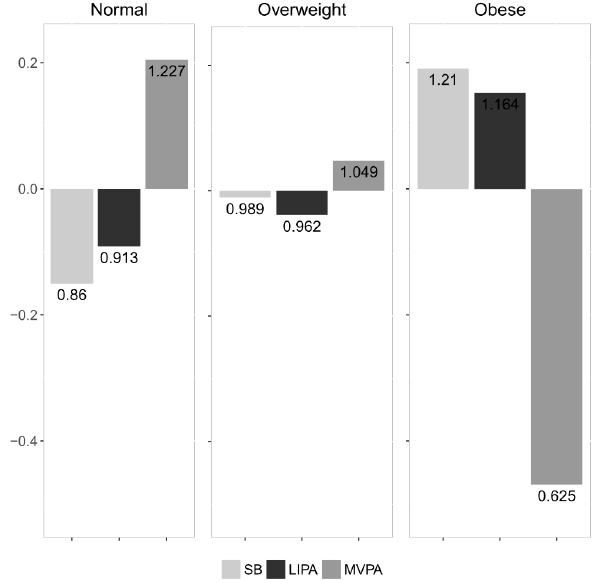
Figure 1. Compositional mean barplot for the BMI categories. The values on the left vertical axis correspond to the log-ratios between the subgroup’s centre and the overall centre after centering the data, whereas the numeric labels of the bars display the actual proportion relative to the overall mean composition.